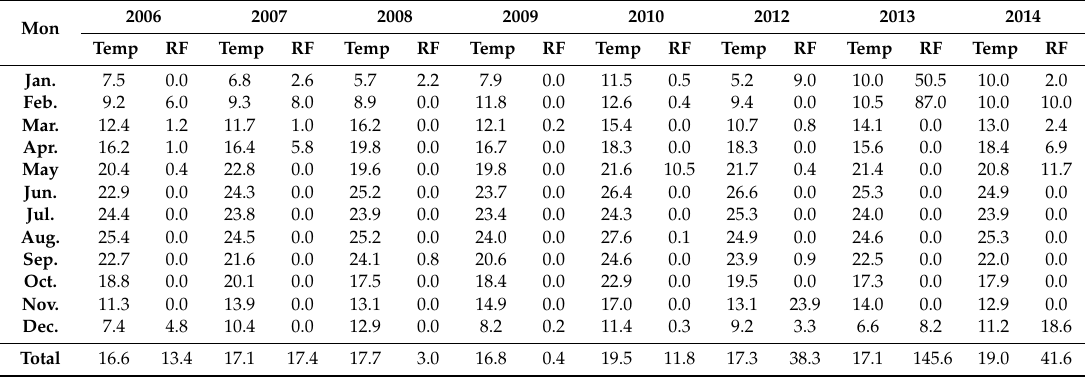
Table 1. Monthly variation in average temperatures ( ◦ C) and rainfall (mm) in the Saint Katherine area from 2006 to 2014, except for 2011 (Saint Katharine Protectorate Weather Station). Temp: Average temperature, RF: Sum